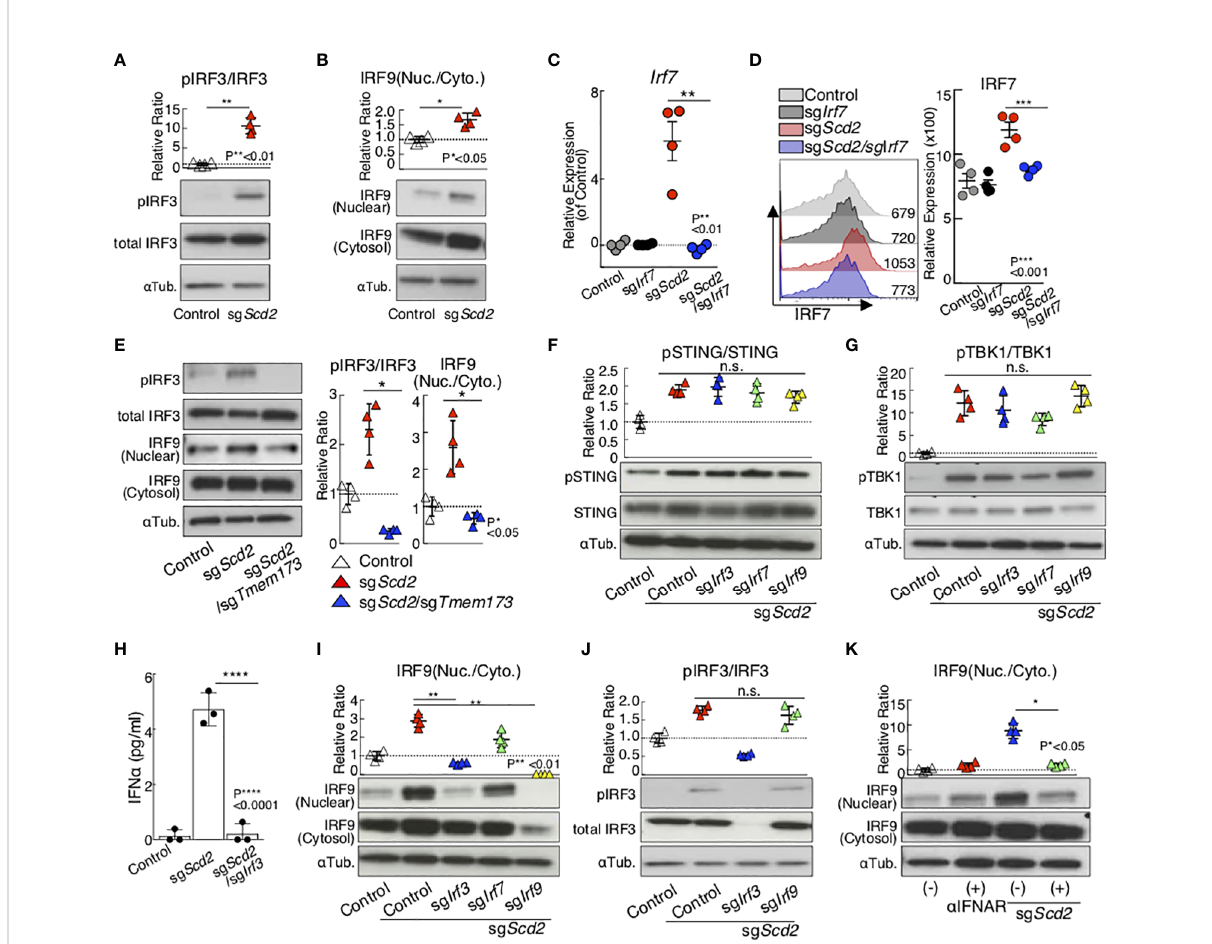
FIGURE 2 Gene deletion of SCD2 resulted in the translocation of IRF3 and IRF9 from cytosolic to nuclear. (A, B) Western blot analysis of phospho-IRF3 (pIRF3), total IRF3 (A) and IRF9 (B) from control and sgScd2 Th1 cells. (C) qRT-PCR analyses of the relative expression of Irf7 from control, sgIrf7, sgScd2 and sgScd2/sgIrf7 Th1 cells. Relative expression (normalized to Hprt) with SD is shown. (D) Intracellular staining and fl ow cytometry analyzing of IRF7 in control, sgIrf7, sgScd2 and sgScd2/sgIrf7 Th1 cells. Mean fl uorescence intensity (MFI) of IRF7 are shown. Summary data of three independent experiments of IRF7 expression are shown here. Each dot represents one experiment. Data are means±SD. (n=3 per each group biologically independent sample). (E) Western blot analysis of pIRF3, total IRF3 and IRF9 from control, sgScd2 and sgScd2/sgTmem173 Th1 cells. (F, G) Western blot analysis of pSTING, total STING (F) and pTBK1, TBK1 (G) from control, sgScd2, sgScd2/sgIrf3, sgScd2/sgIrf7 and sgScd2/sgIrf9 Th1 cells. (H) The amount of IFN a in the cell supernatant was measured by ELISA. Data are means±SD. (I) Western blot analysis of IRF9 from control, sgScd2 and sgScd2/sgTmem173 Th1 cells. (J) Western blot analysis of pIRF3 and total IRF3 from control, sgScd2, sgScd2/ sgIrf3 and sgScd2/sgIrf9 Th1 cells. (K) Western blot analysis of IRF9 from sgScd2 Th1 cells treated with 10 m g/ml IFNAR neutralizing antibody. Isotype antibody was used as control. Band intensity was determined by image j and summary of three independent experiments was shown. Three technical replicates were performed with quantitative RT-PCR and relative expression (normalized to Hprt) with SD is shown (C) .